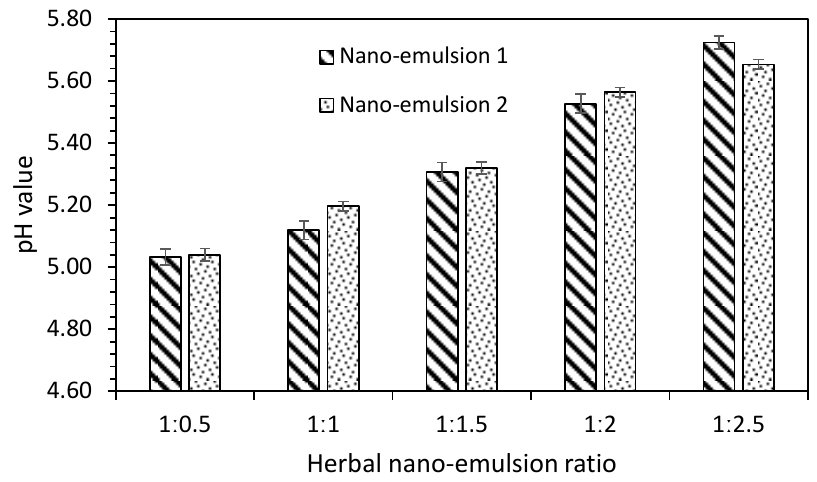
Figure 4. pH value of herbal nano-emulsions.